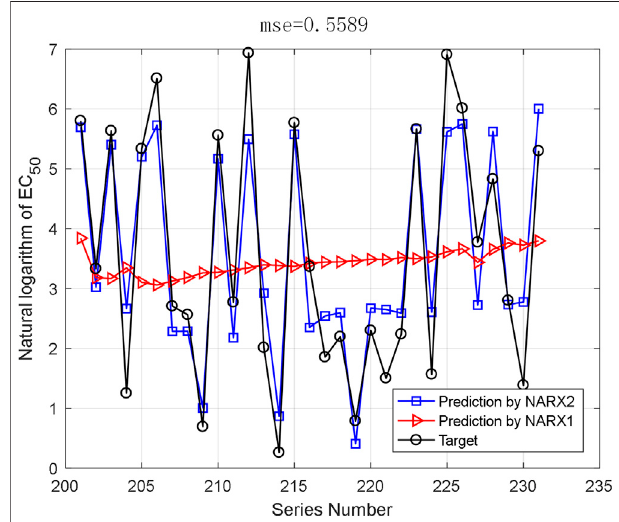
FIGURE 12 | Prediction results by the proposed method.